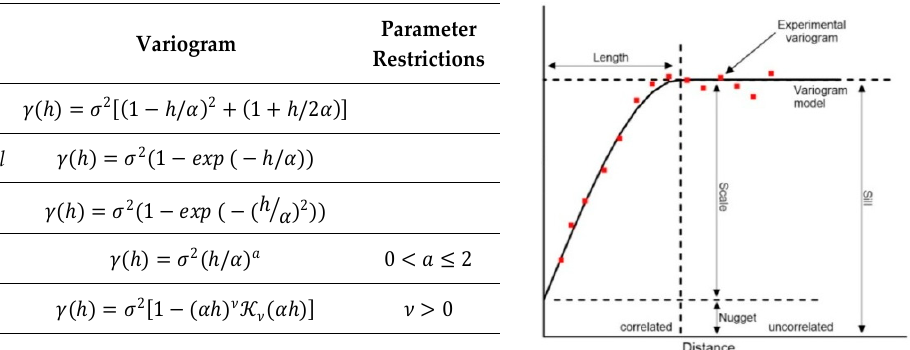
Figure 2. Examples of parametric families of theoretical variograms and experimental and model variograms (red squares and black line, respectively) with corresponding parameters, on the left and right respectively. The parameter σ 2 (the partial sill) identifies the variance of the process and is always positive; the parameter α (the range) identifies the length of the spatial process and is also positive. Other parameter restrictions are reported in the last column.